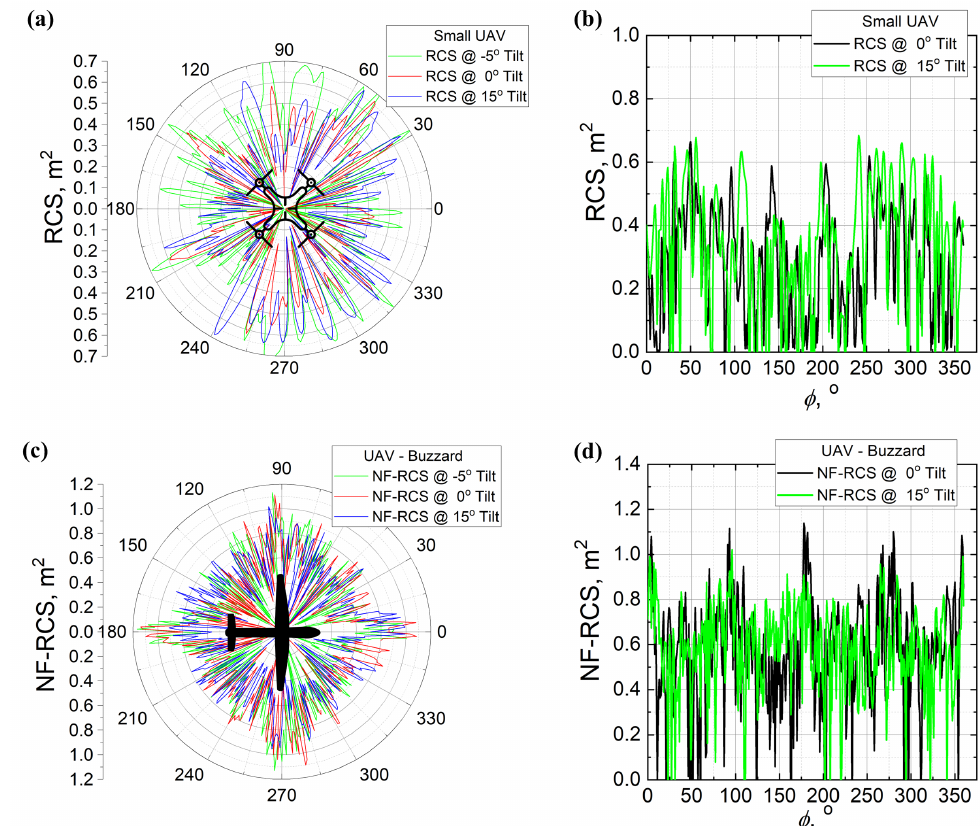
Figure 6. Radar cross-section measurements. RCS of quadcopter small UAV—polar ( a ) and rectangu- lar ( b ) plot , near-field RCS of fixed-wing UAV Buzzard—polar ( c ) and rectangular ( d ) plot.